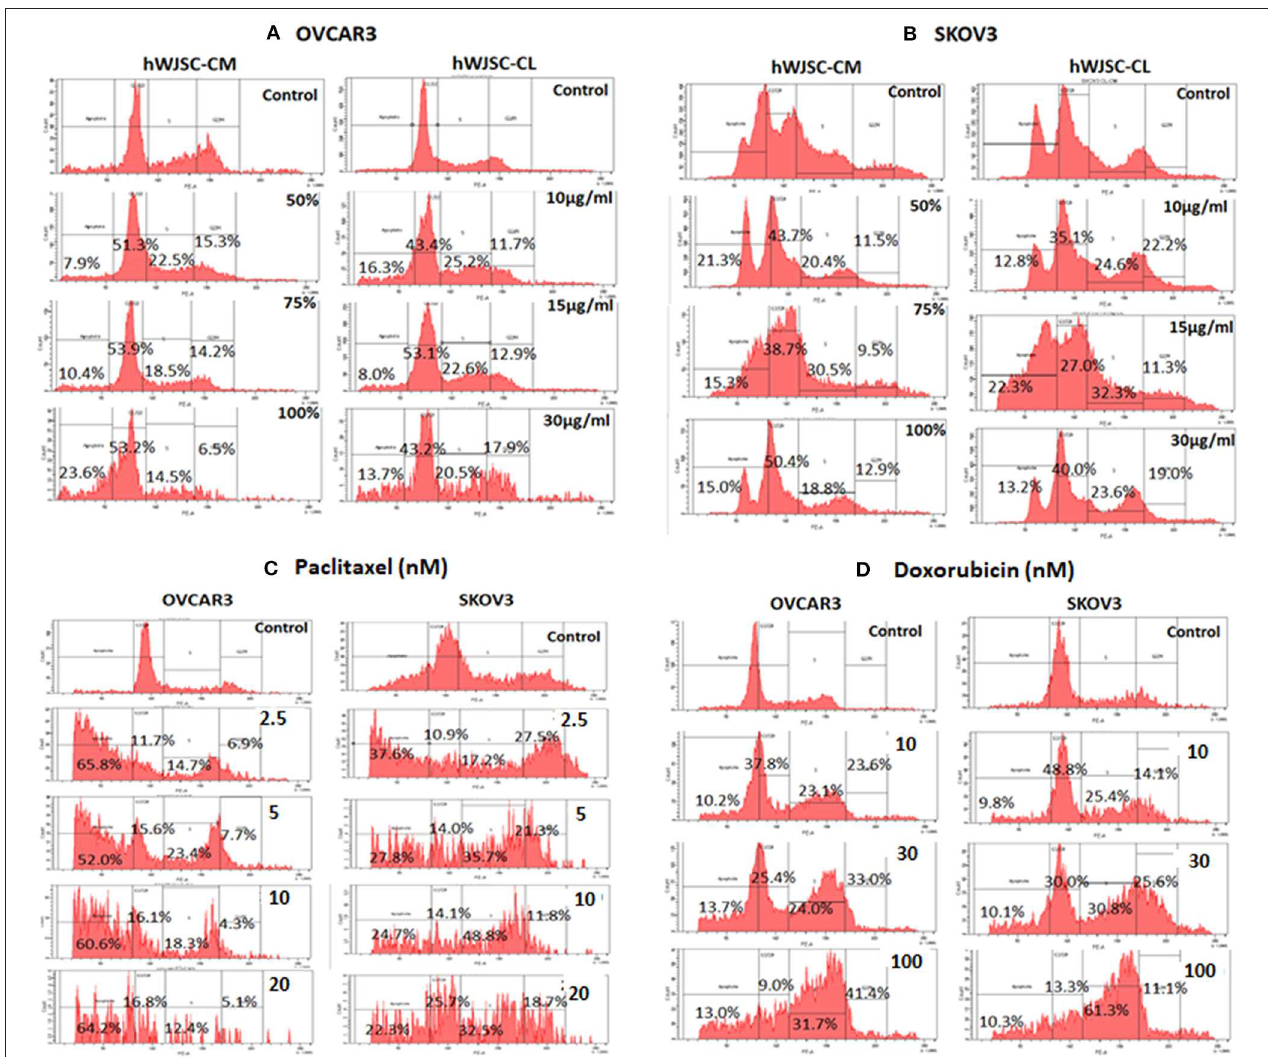
FIGURE 6 | Cell cycle assay of (A) OVCAR3 cells treated with hWJSC-CM (left panel) and hWJSC-CL (right panel); (B) SKOV3 cells treated with hWJSC-CM (left panel) and hWJSC-CL (right panel); (C) OVCAR3 cells (left panel) and SKOV3 (right panel) cells treated with paclitaxel; (D) OVCAR3 cells (left panel) and SKOV3 (right panel) cells treated with doxorubicin. Treatment of both OVCAR3 and SKOV3 cells with hWJSC-CM (50, 75, 100%), hWJSC-CL (10, 15, 30 µ g/ml), paclitaxel (2.5, 5, 10nM), and doxorubicin (10, 30, 100nM) for 48h showed an increase in the sub-G1 and G2M phases of cell cylce indicative of apoptosis and metaphase arrest, respectively. The values are expressed as mean ± SEM of three different